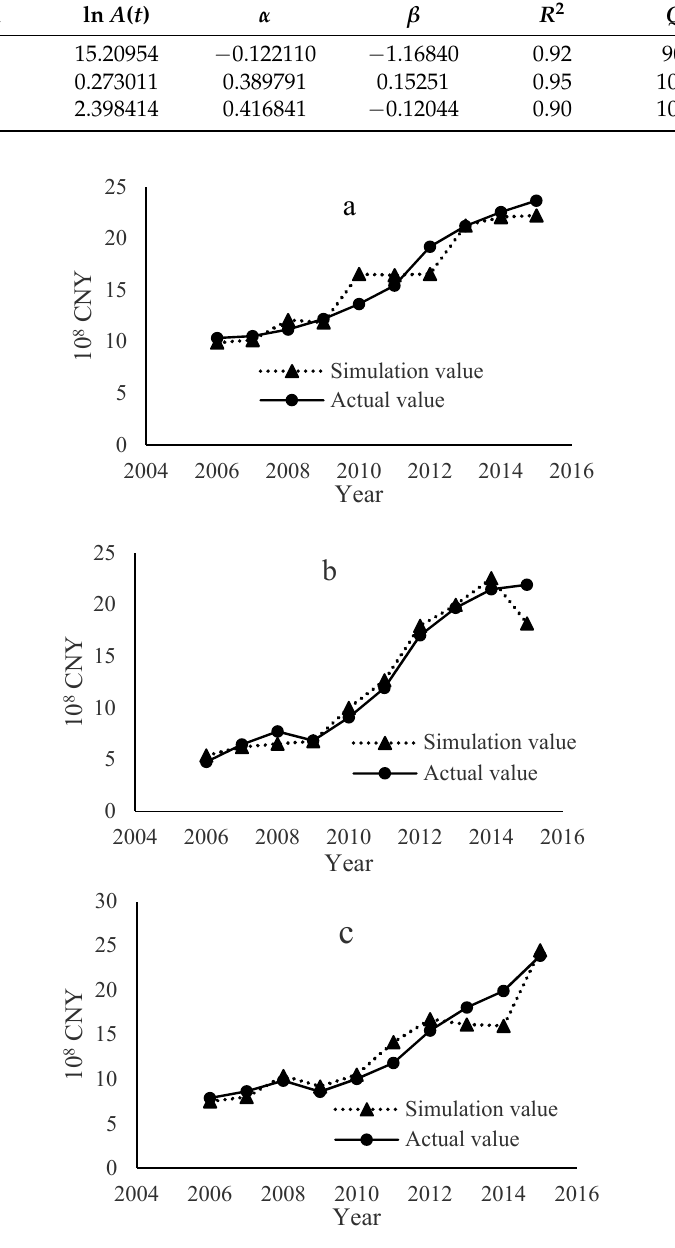
Figure 3. Comparison between simulation results and actual values of PI ( a ), SI ( b ), and TI ( c ).